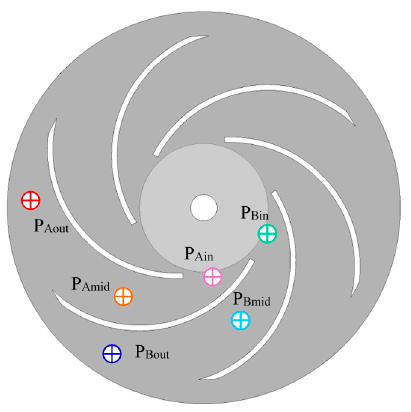
Figure 14. Monitoring points for pressure pulsations.